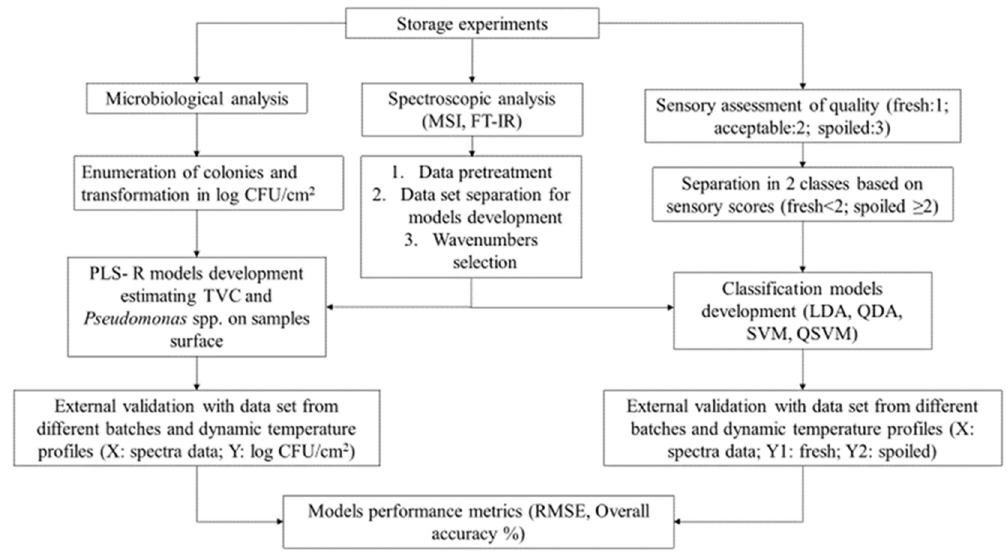
Figure 1. Flowchart describing quantitative and qualitative model development and validation. PLS-R models for the estimation of TVCs and Pseudomonas spp. counts on chicken thighs surface were developed and validated by the software Unscrambler © ver. 9.7